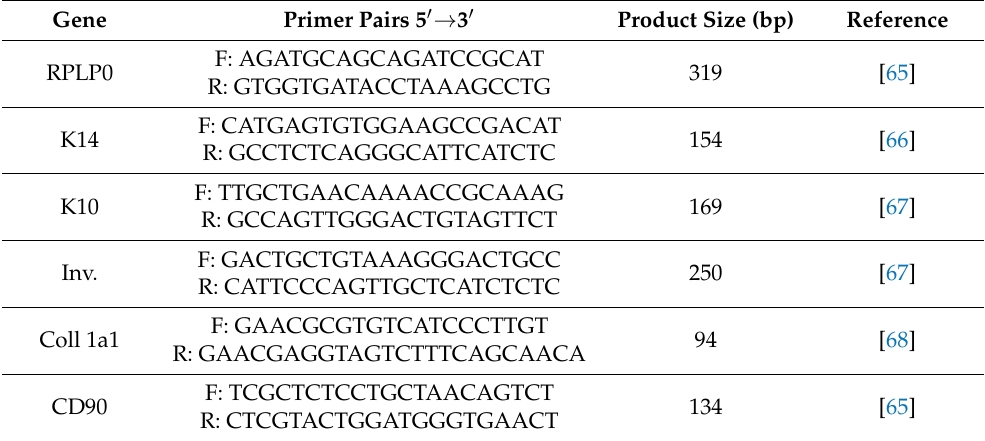
Table 1. The list of human primers used in qRT-PCR.